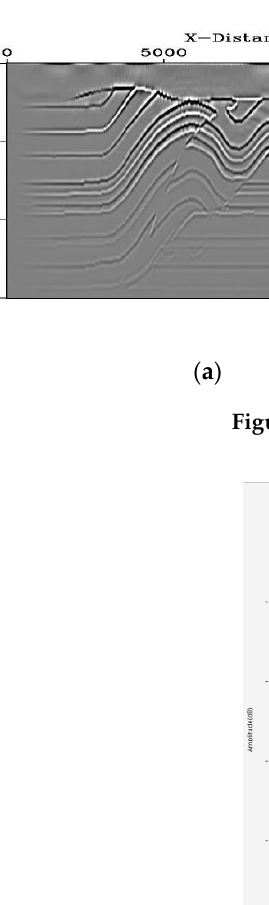
Figure 5. The 3D data volume of LSM in the 3D Overthrust model.